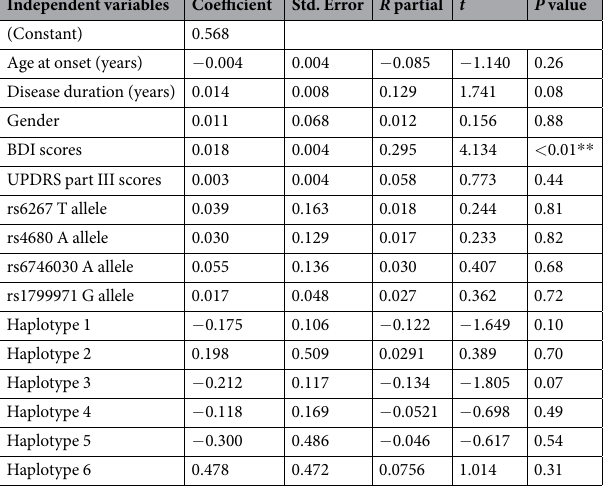
Table 2. Multiple stepwise regression analysis of factors correlated with susceptibility of pain in patients with PD (n = 418). In this model, the presence of pain in patients with PD was set as the dependent variable and the onset age of PD motor symptoms, disease duration, sex, BDI scores, UPDRS part III scores in the on state of PD, and minor allele frequency of pain-related candidate genes in this study were set as the independent variables (adjusted R 2 = 0.451 and P = 0.002). R: correlation coefficient based on the model of logistic regression; t : t value for the coefficient of each parameter in the model; p : for R or t . BDI, Beck Depression Inventory; UPDRS, Unified PD rating scale. The sequence of alleles in each haplotype for central haploblock of COMT gene reflects the order of occurrence from 5 ′ to 3 ′ in the COMT gene (SNPs: rs6269, rs4633, rs4818 and rs4680, respectively). Six haplotypes out of possible 16 were detected from these four SNPs with the most frequent haplotype (Haplotype 1, 24.6%) composed of the most frequent alleles for SNPs rs4633 and rs4680 and the least frequent alleles for SNPs rs6269 and rs4818 (G_C_G_G for SNPs rs6269, rs4633, rs4818 and rs4680, respectively). The second major haplotype (Haplotype 2, 24.3%) was composed of the most frequent alleles for SNPs rs6269 and rs4818 and the least frequent alleles for SNPs rs4633 and rs4680 (A_T_C_A). The third haplotype (Haplotype 3, 16.1%) was composed of a combination of the most frequent alleles for all SNPs (A_C_C_G). The